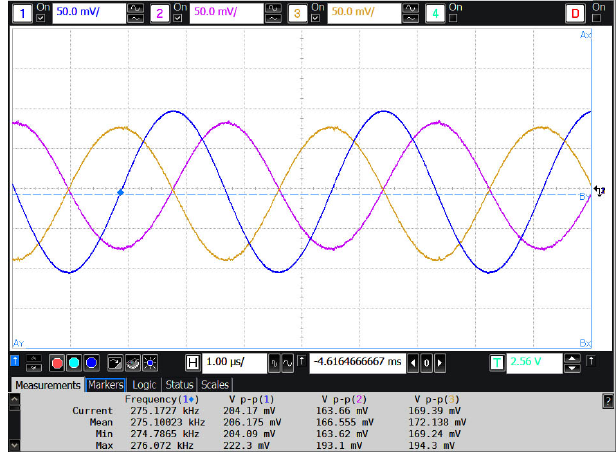
Figure 6. Measured time-domain waveforms (blue line—input, orange line— V o1 , pink line— V o2